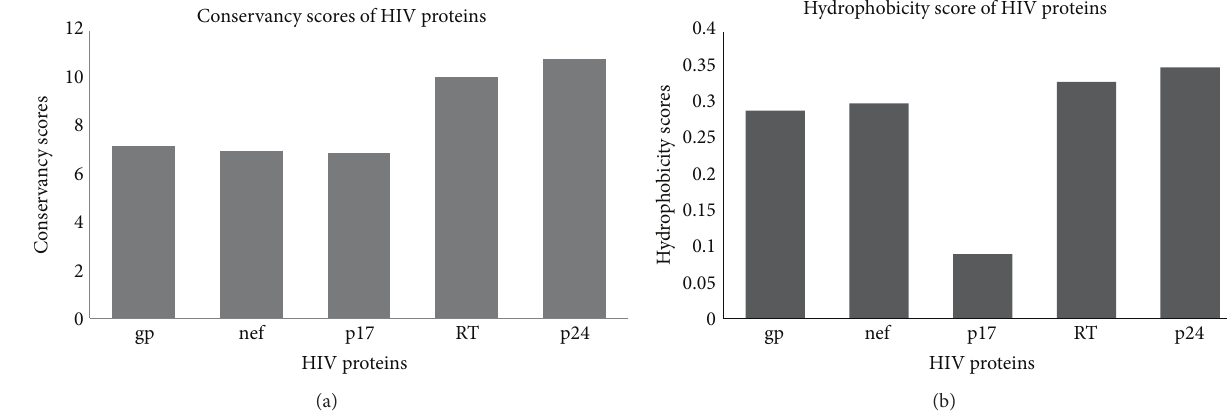
Figure 3: Cumulative conservancy (a) and hydrophobicity (b) scores of five individual proteins of HIV-1.